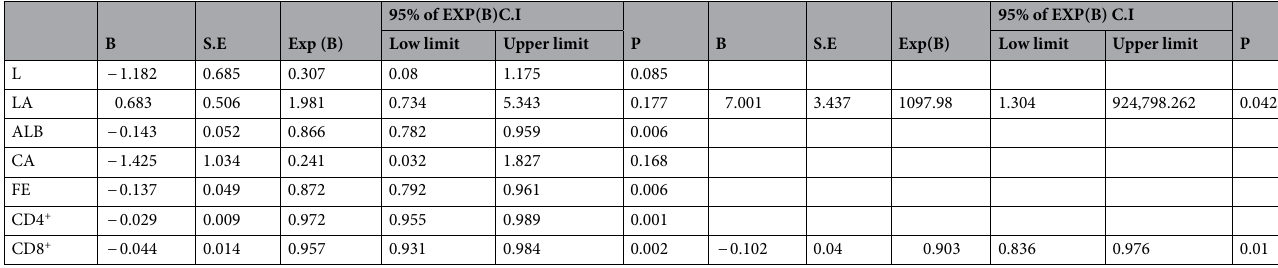
Table 4. Univariate and multivariate analysis of the transition from light or ordinary to heavy or critical in training set.